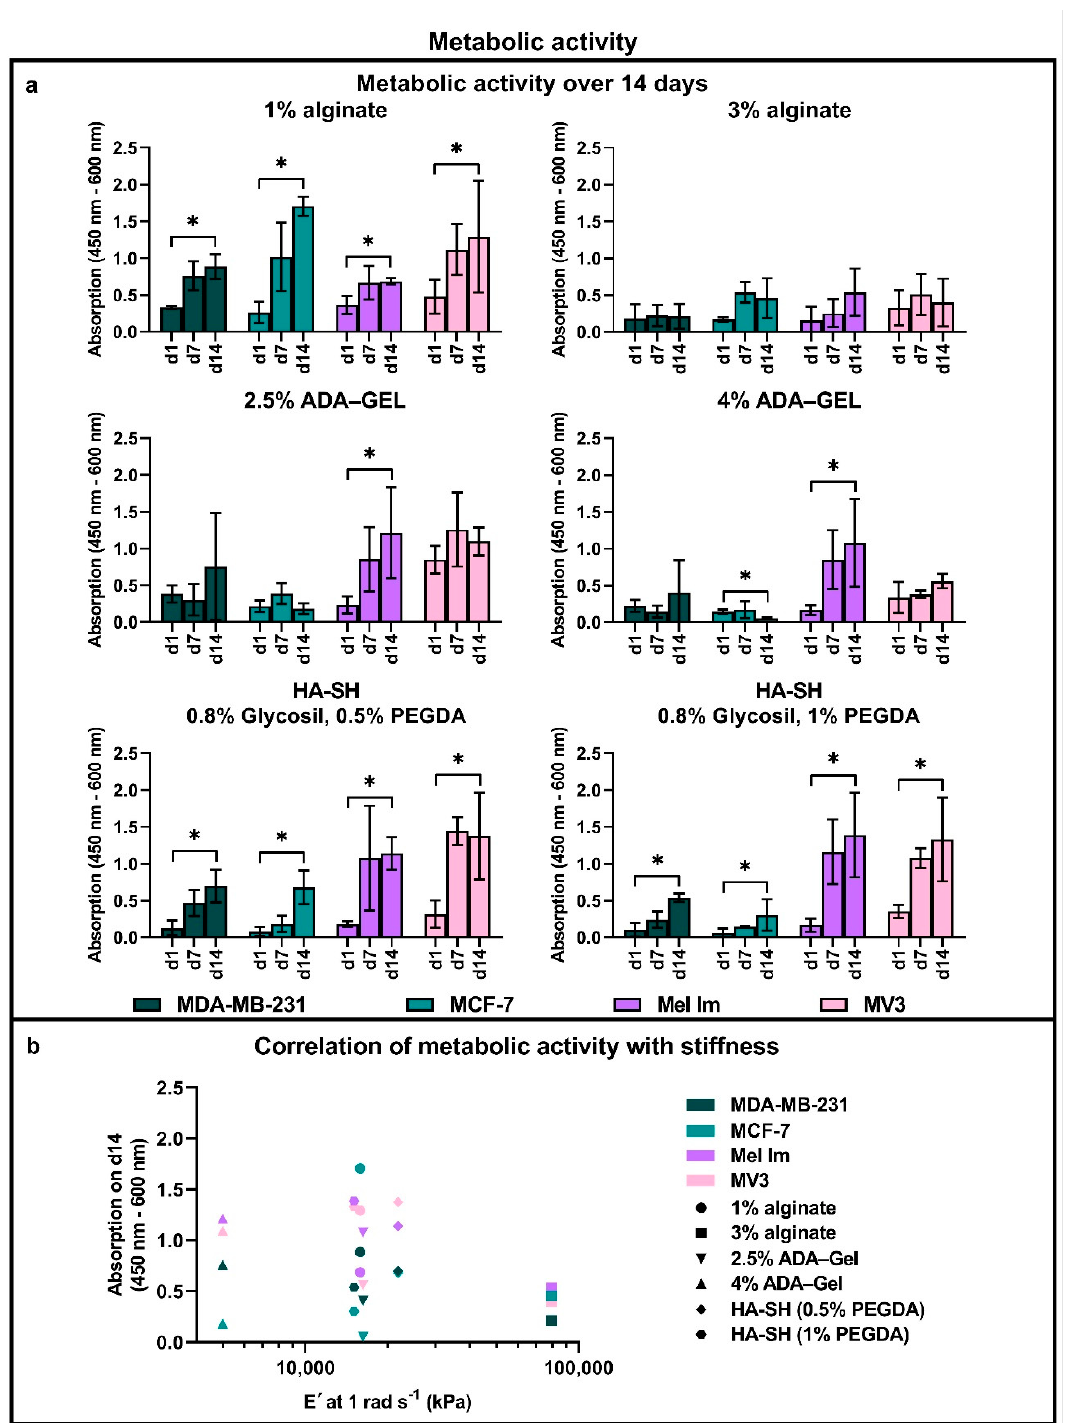
Figure 3. Cell metabolic activity of four cell lines ( a ) in alginate, ADA–GEL, and HA-SH, measured by using a WST-8 assay over 14 days; not all significances are shown for better clarity but mentioned in the results; data shown as mean ± SD of biological replicates, * p ≤ 0.05 Kruskal–Wallis H test, Mann–Whitney U test, n = 3; ( b ) correlation of the metabolic activity of four cell lines on day 14 with the stiffness of different hydrogels.